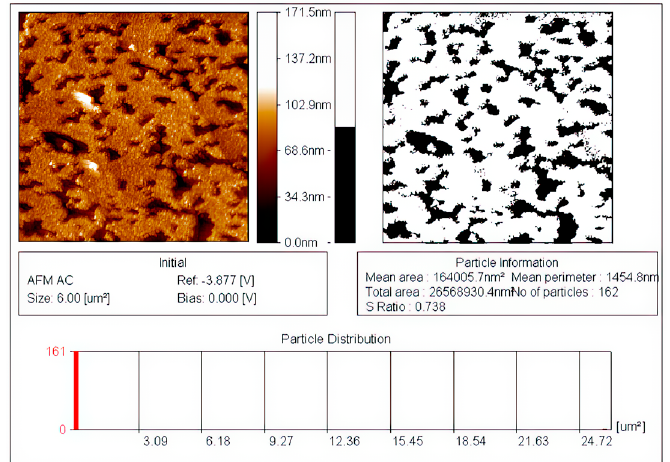
Figure 2. Detailed information of AFM images of an uncoated sample: the ratio of the area occupied by pores to the total surface area of the sample.